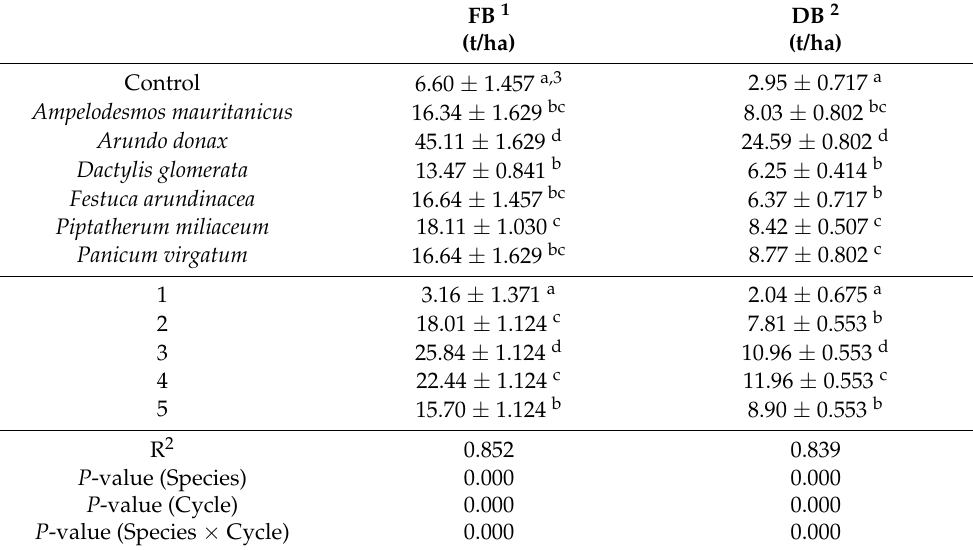
Table 2. Fresh and dry biomass of the different perennial grasses assayed throughout the whole experiment and for the different growing seasons considering all the species tested